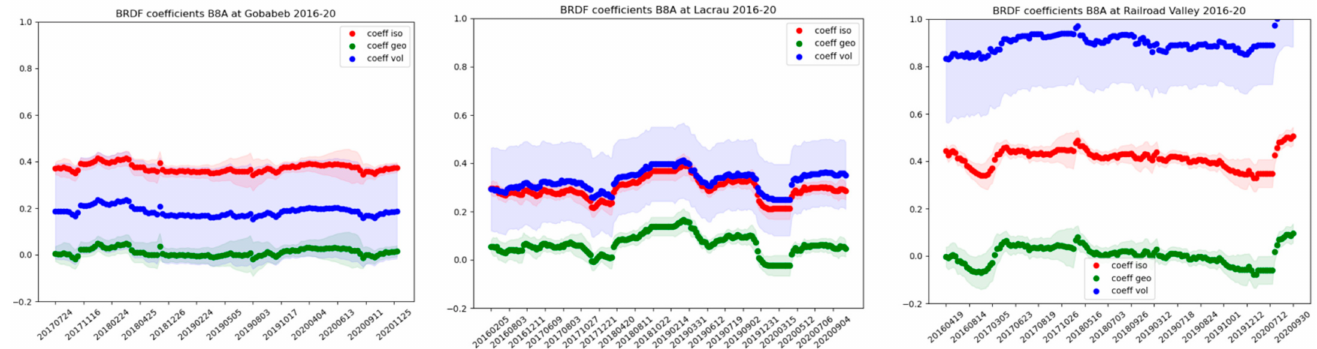
Figure 2. Time series of BRDF cefficients using the Roujean Kernels and the Kalman filtering approach, and related uncertainties for each